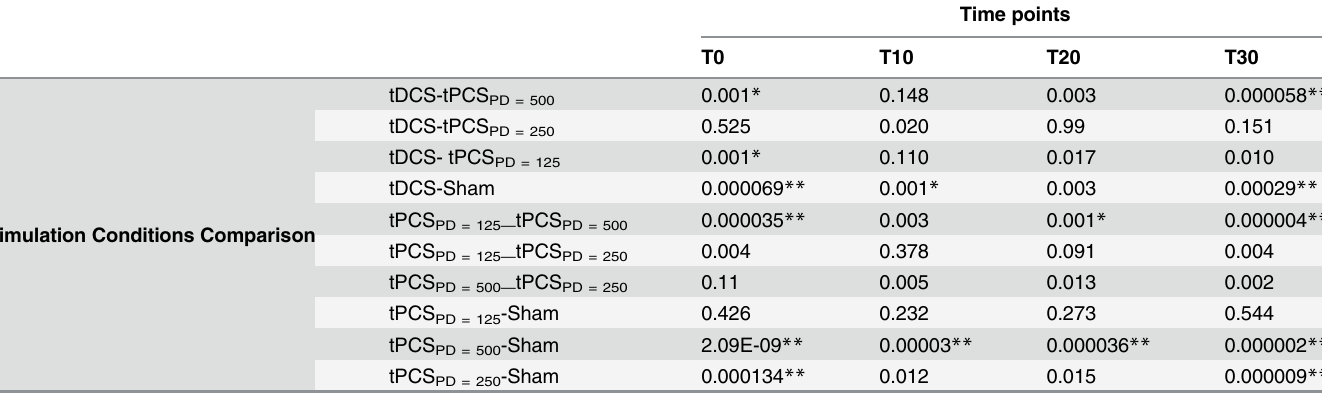
Table 4. Significant interactions between mean MEPs of different conditions in different time points. The results were considered significant at the level of P (cid:3) 0.001.